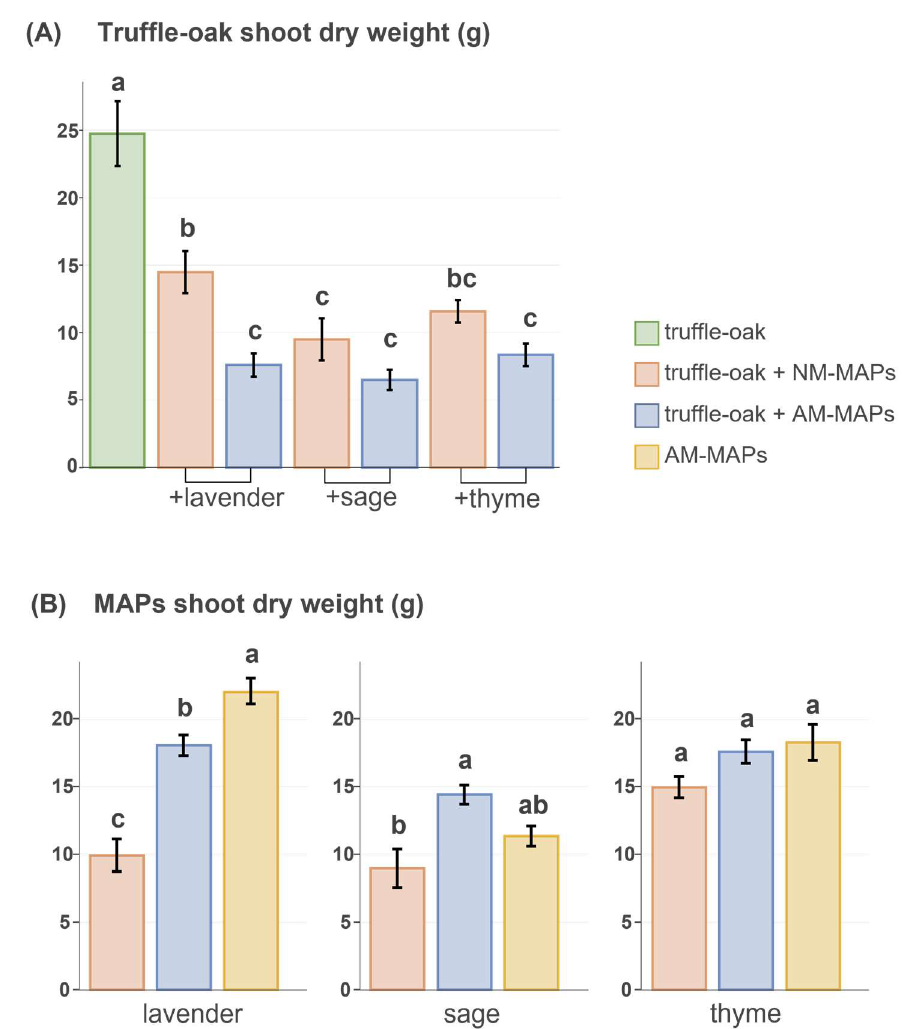
Figure 2. ( A ) Shoot dry weight of truffle-oak seedlings growing alone ( n = 7, green) or in the presence of MAPs, either non-inoculated (NM, n = 7 per species, pink) or inoculated with AMF (AM, n = 7 per species, blue). ( B ) Shoot dry weight of lavender, sage, and thyme co-cultured with truffle-oaks and either non-inoculated (NM, pink) or inoculated with AMF (AM, blue), and growing alone ( n = 5 per species, yellow). Data include means ± standard errors. Significant differences between means were analyzed by ANOVA for each MAP species separately and by ANCOVA in the case of truffle-oaks with the initial height as covariate. Treatments sharing the same lowercase letter are not significantly different (Tukey’s test, p <